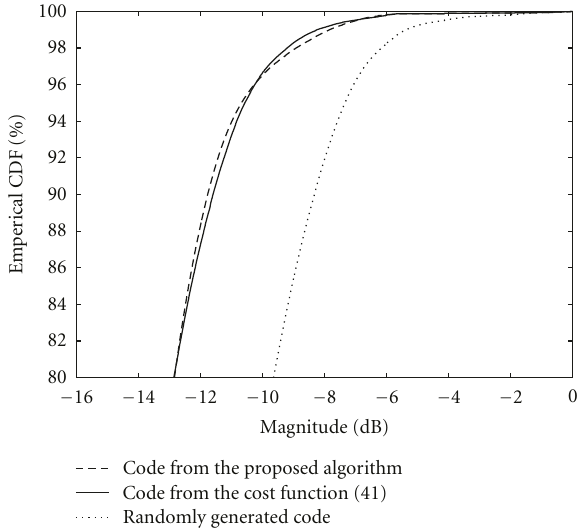
Figure 14: Empirical CDFs of the codes from the two methods ( M = 4, Q = 10, and K = 20).